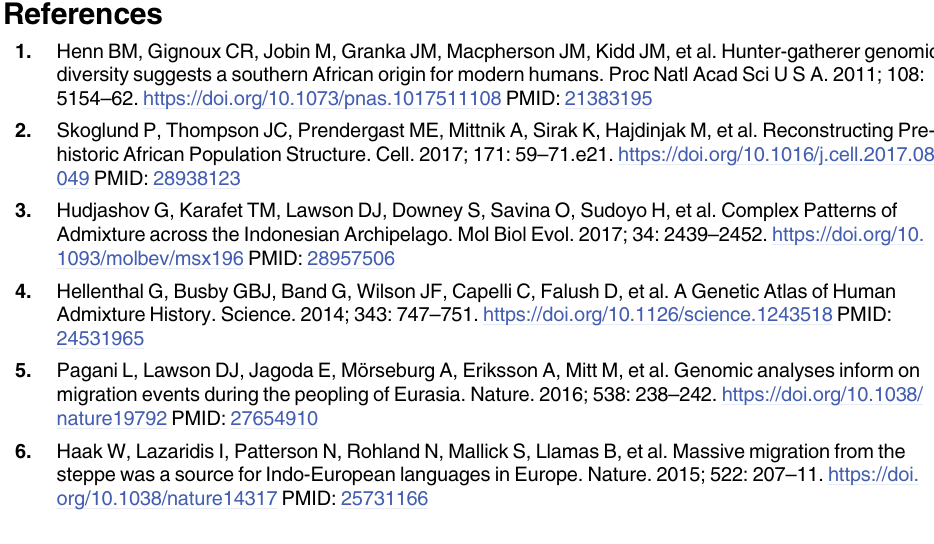
S3 Table. Loci with the strongest signals for positive selection in North Eurasia popula- tions identified by whole-genome allele frequency analysis. File includes complete list of individuals whose genome sequences have been analyzed. The table contains the EGDP identi- fiers of each person (in the first column), the population name (in the second column), the country of origin (in the third column), and the name of the corresponding population group (one of our 12 groups) (in the fourth column). Columns representing SNPs from Tables 3 and 4 are highlighted in yellow or red. The alleles in these columns are presented in a standard VCF format: 0|0 means the person is homozygous with reference allele, 1|1 means that the per- son is homozygous with alternative allele, while 0|1 or 1|0 means that the person is heterozy- gous for this